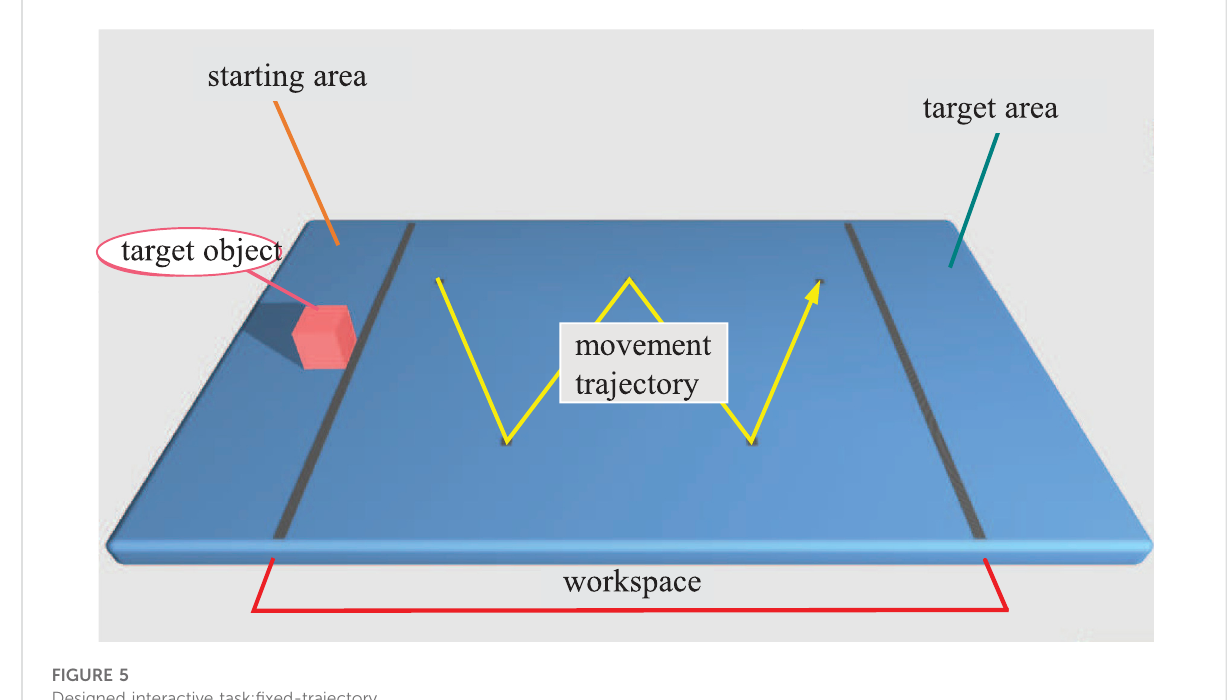
FIGURE 5 Designed interactive task: fi xed-trajectory.